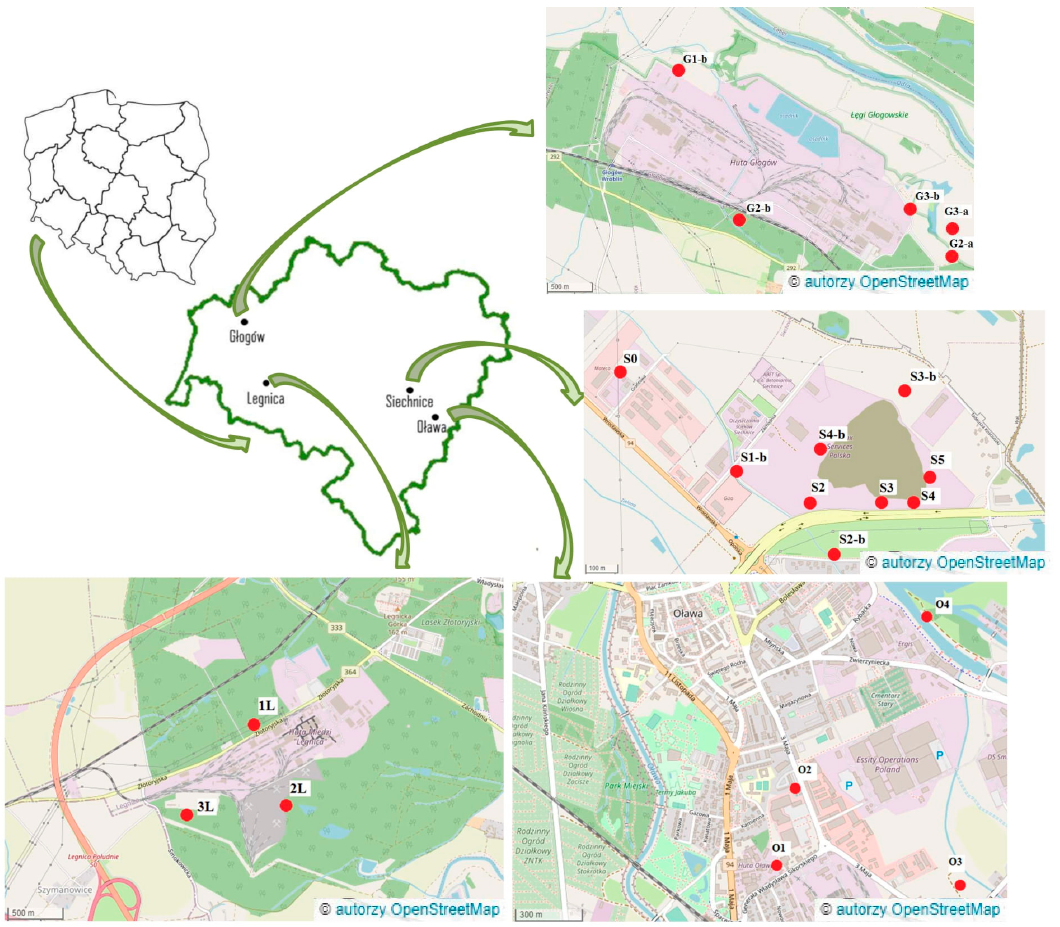
Figure 1. Studied smelters with sampling points on the map of Lower Silesia. Adapted with per-